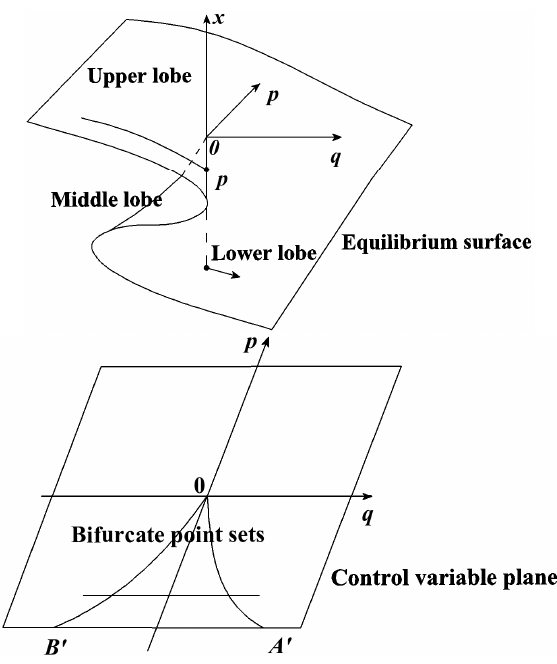
Figure 10. The equilibrium surface and the control variable plane.